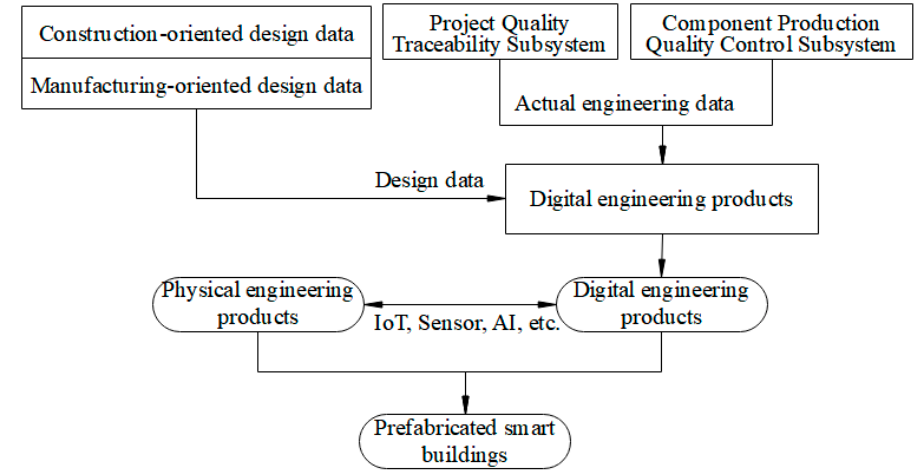
Figure 5. The operation mechanism of ICSPB-IoT in the product delivery stage.